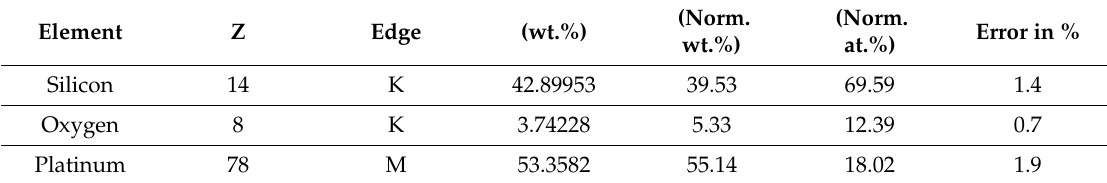
Table 1. EDS elemental analysis for Pt thin film deposited on Si substrate.